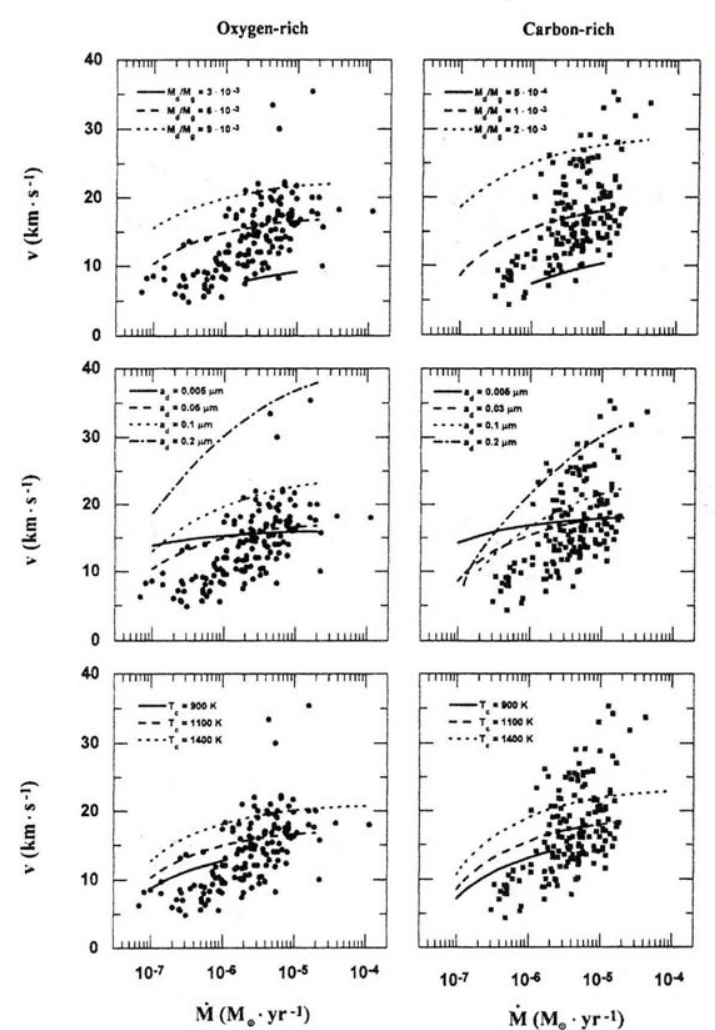
Fig. 2. Terminal outflow velocity versus mass-loss rate for the cal- culated models and individual stars. All model parameters which are not varied are those of the standard model (Table 1). Curves present model calculations for different dust-to-gas ratios (upper raw), grain radii (mid- dle raw) and dust condensation temperatures (bottom raw). Individual observations are plotted as dots (oxygen-rich stars, left panels) and squares (carbon-rich stars, right